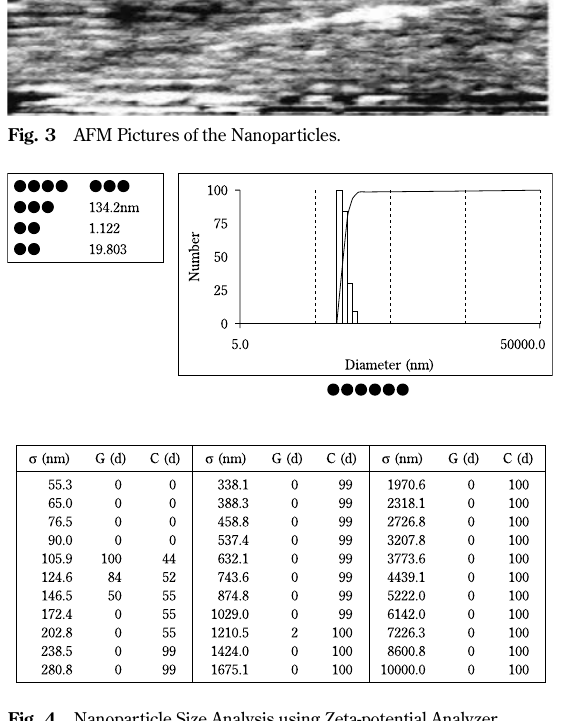
Fig. 4 Nanoparticle Size Analysis using Zeta-potential